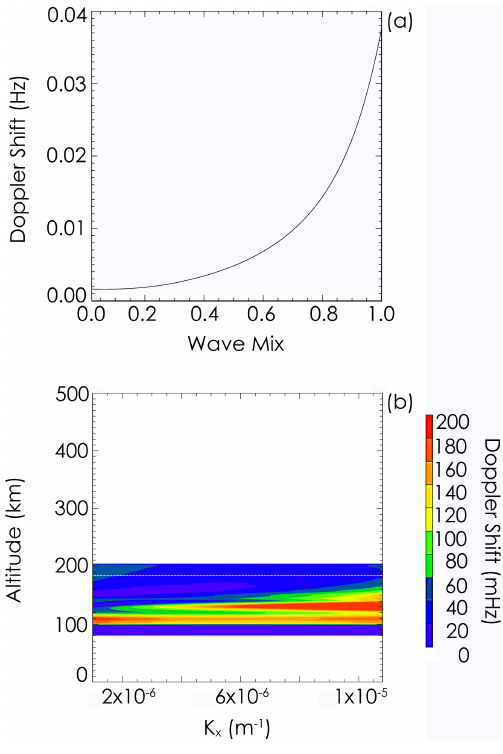
Fig. 9. Panel (a) shows the overall Doppler shift model results of the ULF wave event on 16 April 1998 between 09:45UT–10:45UT for wave mixes ranging between zero and unity. The panel shows the variation of total Doppler shift with wave mix at the DOPE re- flection altitude of 184km. Panel (b) presents the variation in the total Doppler shift contributions as a function of altitude and k x The overplotted white dashed line shows the DOPE reflection altitude at approximately 184km. The ground magnetic field in both panels has been scaled to